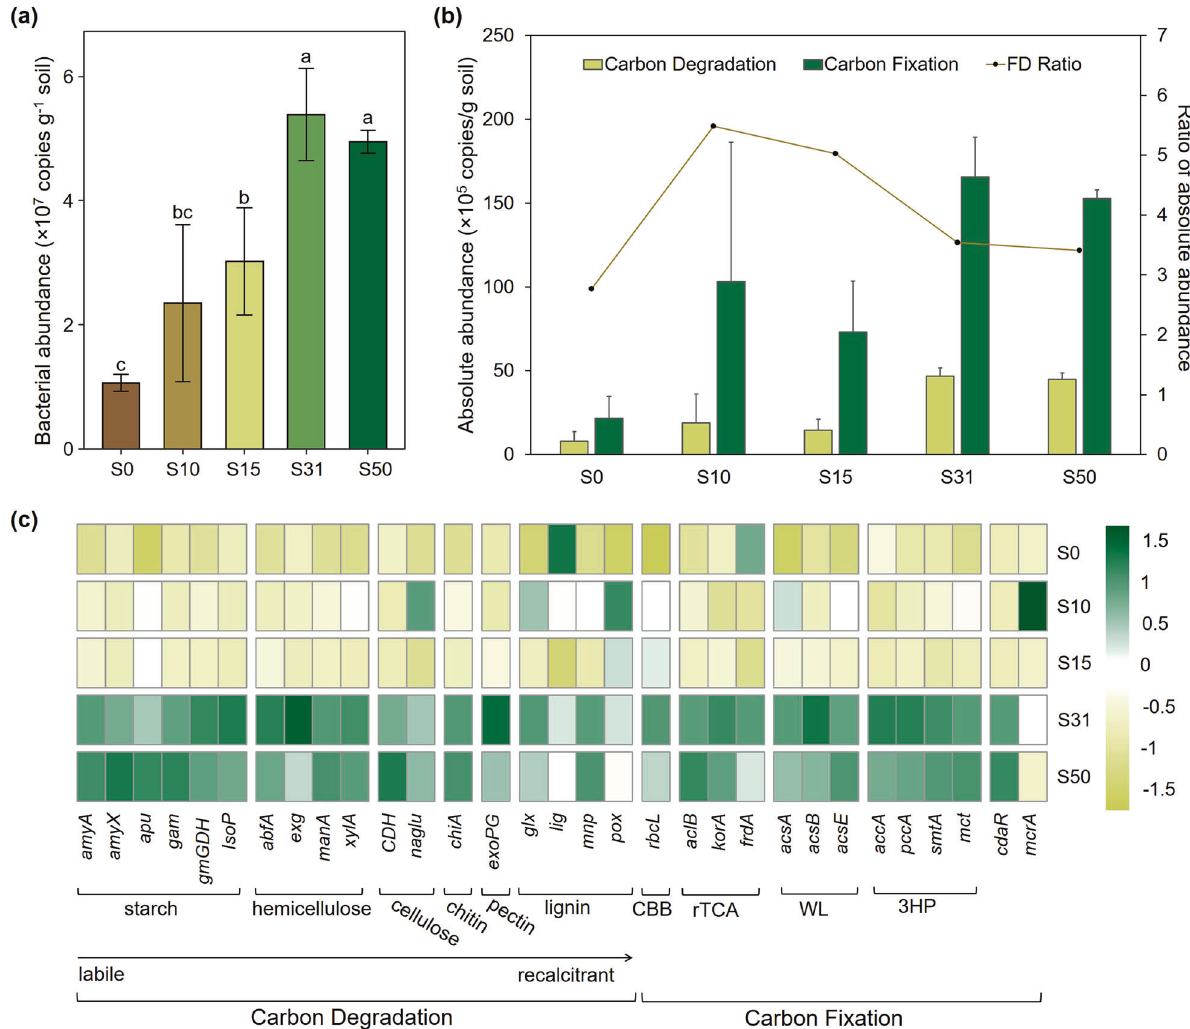
Fig. 3 Absolute copy number of soil bacteria and functional genes in the glacier foreland of Laohugou Glacier No. 12. a Soil bacterial copy number; b absolute abundance and ratio (FD ratio) between carbon fi xation and carbon degradation genes; c heatmap of absolute abundance of all functional genes. The numbers in the fi ve sampling sites represent the retreat years (S0, S10, S15, S31, and S50). Different letters indicate signi fi cant differences among sites ( p < 0.05). CBB, rTCA, WL, and 3HP represent the reductive pentose phosphate cycle, reductive tricarboxylic acid cycle, reductive acetyl-CoA pathway, and 3-hydroxypropionate bicycle carbon fi xation pathways, respectively. Green shading indicates a higher absolute abundance, whereas yellow shading indicates a lower absolute abundance. 5.81% at S50 (Table 1). Accounting for 20.52% of all carbon- fi xation genes at S0, the genes involved in the reductive Table S3). tricarboxylic acid (rTCA) cycle decreased to 5.96% at S50 (911.23 × 10 3 copies g − 1 soil) (Table 1 and Table S3). Microbial community composition After fi ltering out the unquali fi ed sequences, a total of 437,265 Similarly, the relative abundance of carbon degradation gene high-quality sequences in the V3V4 region of 16 S rRNA gene were groups could be obtained as Table 1. The genes responsible for obtained, and the corresponding rarefaction curve is shown in hemicellulose degradation were the most prevalent among all Fig. S2. These sequences were clustered into 7693 OTUs, including genes of carbon degradation, regardless of successional zone 35 phyla. In the fi ve successional zones of Laohugou Glacier No. 12 (Table 1). Proportion of hemicellulose degradation genes ’ foreland, the dominant phyla were Actinobacteria and Proteo- abundance to total carbon degradation genes ’ abundance bacteria (Fig. 4a). The relative abundance of Proteobacteria increased from 46.03% (S0: 361.74 × 10 3 copies g − 1 soil) to decreased remarkably from 39.64% at S0 to 12.32% at S50 64.70% (S50: 2900.58 × 10 3 copies g − 1 soil). Genes related to lignin (Fig. 4a), and the relative abundance of Bacteroidetes decreased and starch degradation were also dominant in carbon degradation by 12.64%. The abundance of Cyanobacteria continually genes, whose proportion decreased from 50.05% (S0: lignin: decreased to 2.05% at S31 from 8.69% (S0), later showing a slight 28.95%, starch: 21.09%) to 32.46% (S50: lignin: 13.12%, starch: increase to 4.83% at S50 (Fig. 4a and Fig. S3). Chloro fl exi showed a 19.34%) (Table 1). Moreover, the absolute abundance of genes volatile decrease along the chronosequence from 3.64% (S50) to involved in starch degradation (867.02 × 10 3 copies g − 1 soil, 1.50% (S0) (Fig. 4a and Fig. S3). In contrast, Acidobacteria, with a 19.34%) at S50 was higher than that of those involved in lignin